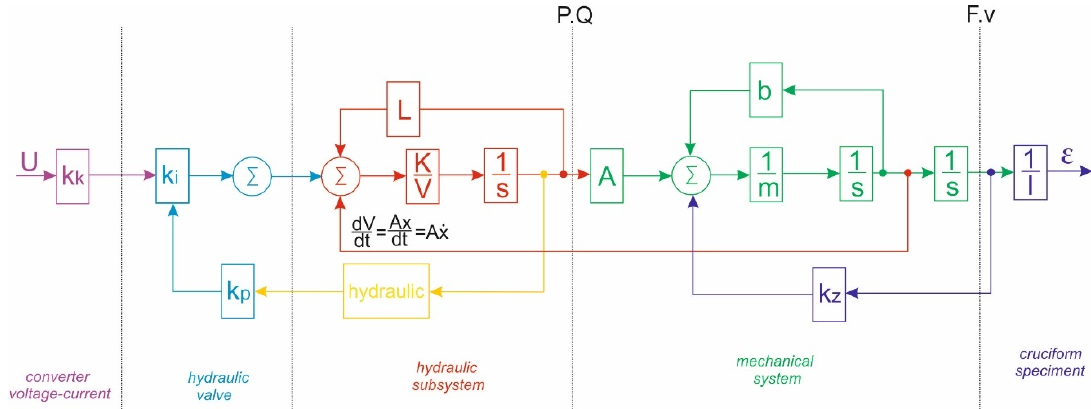
Figure 15. The final form of the closed-loop block diagram of the testing system.